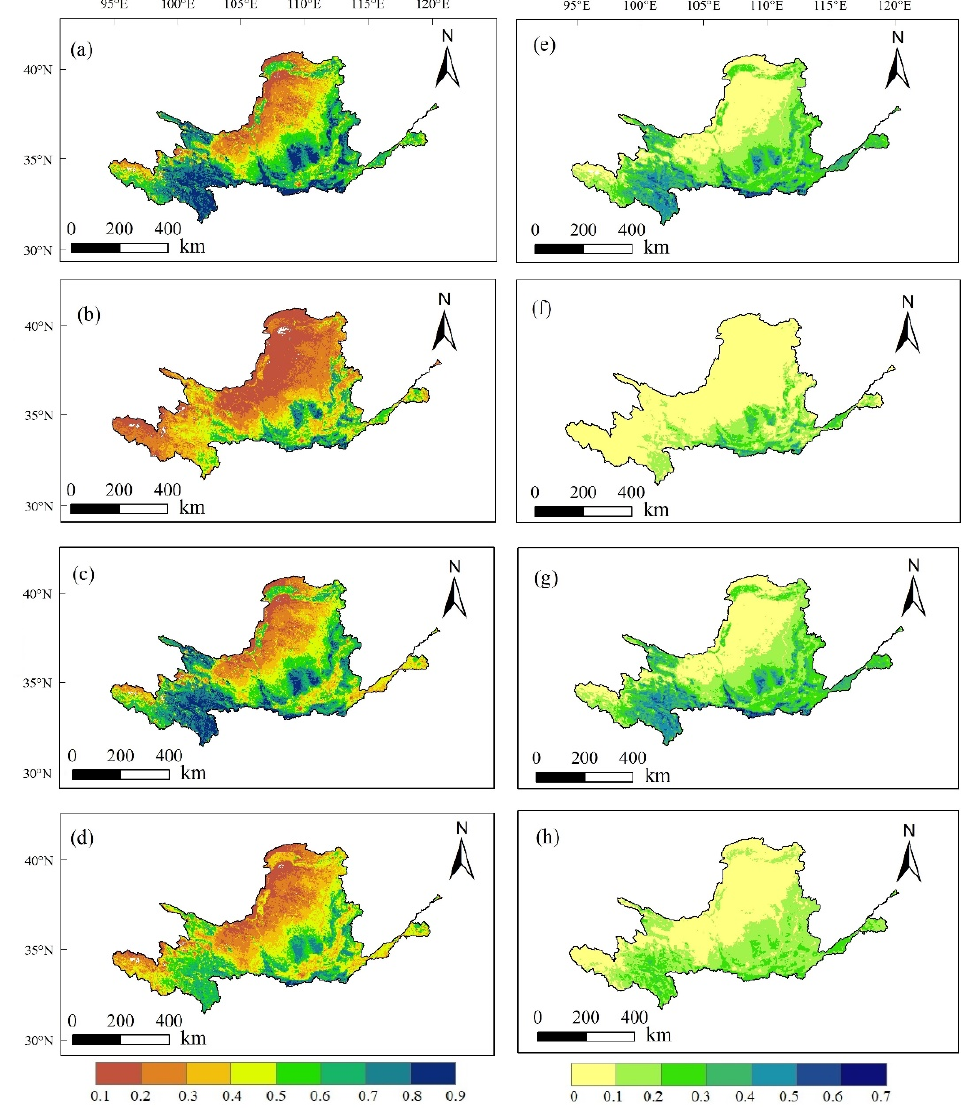
Figure 7. Spatial variation of average NDVI and SIF in different seasons ( a – h ). ( a ) Annual average NDVI; ( b ) Spring average NDVI; ( c ) Summer average NDVI; ( d ) Autumn average NDVI; ( e ) Annual average SIF; ( f ) Spring average SIF; ( g ) Summer average SIF; ( h ) Autumn average SIF.